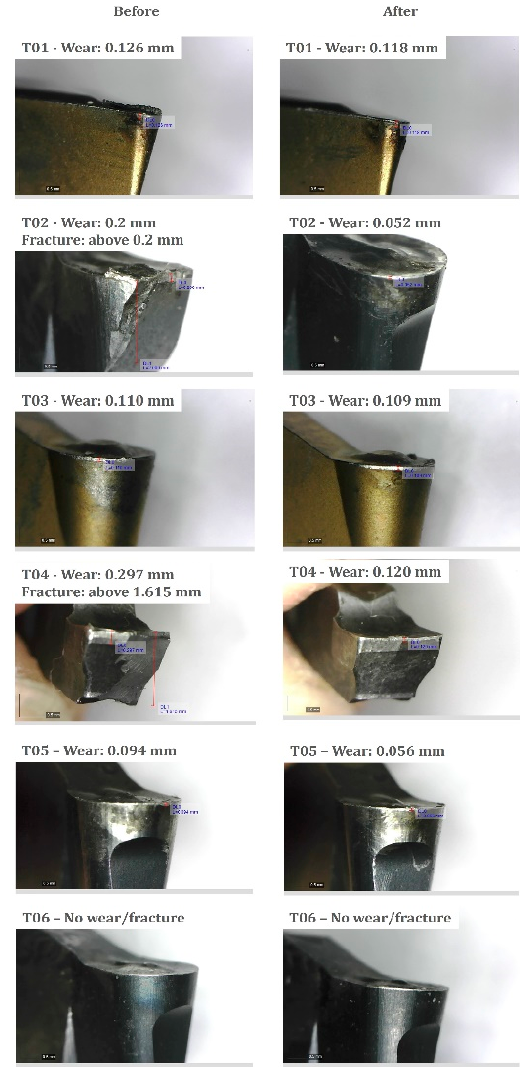
Figure 7. Cutting tool wear at semi-finishing.